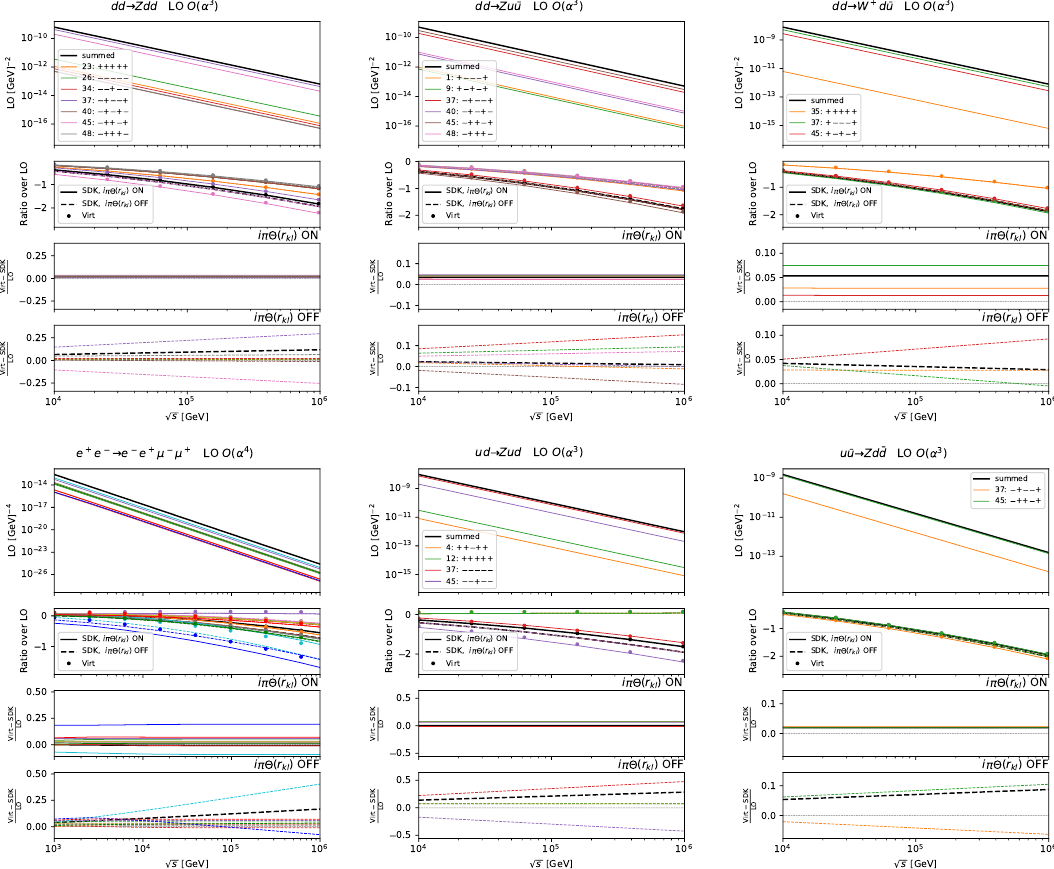
Figure 3 . Comparison between exact results (dots) for O ( (cid:11) ) NLO EW virtual corrections and their LA (lines) in the case of squared matrix elements of representative 2 ! n processes with n = 3 ; 4 . Solid lines include the contributions proportional to i(cid:25) (cid:2)( r kl ) , while dashed lines do not. Plots show a scan in energy for fixed r kl =s ratios. More details are given in the